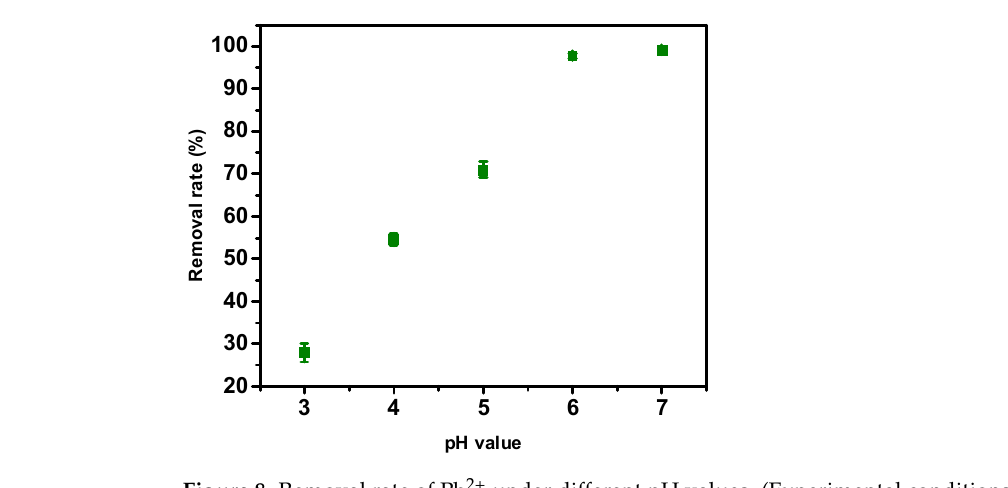
when the initial concentration of Pb 2+ was 10 mg/L and reached 1187 μ mol/g at 30 mg/L and 1235 μ mol/g at 90 mg/L. As the initial concentration of Pb 2+ continued to increase, the